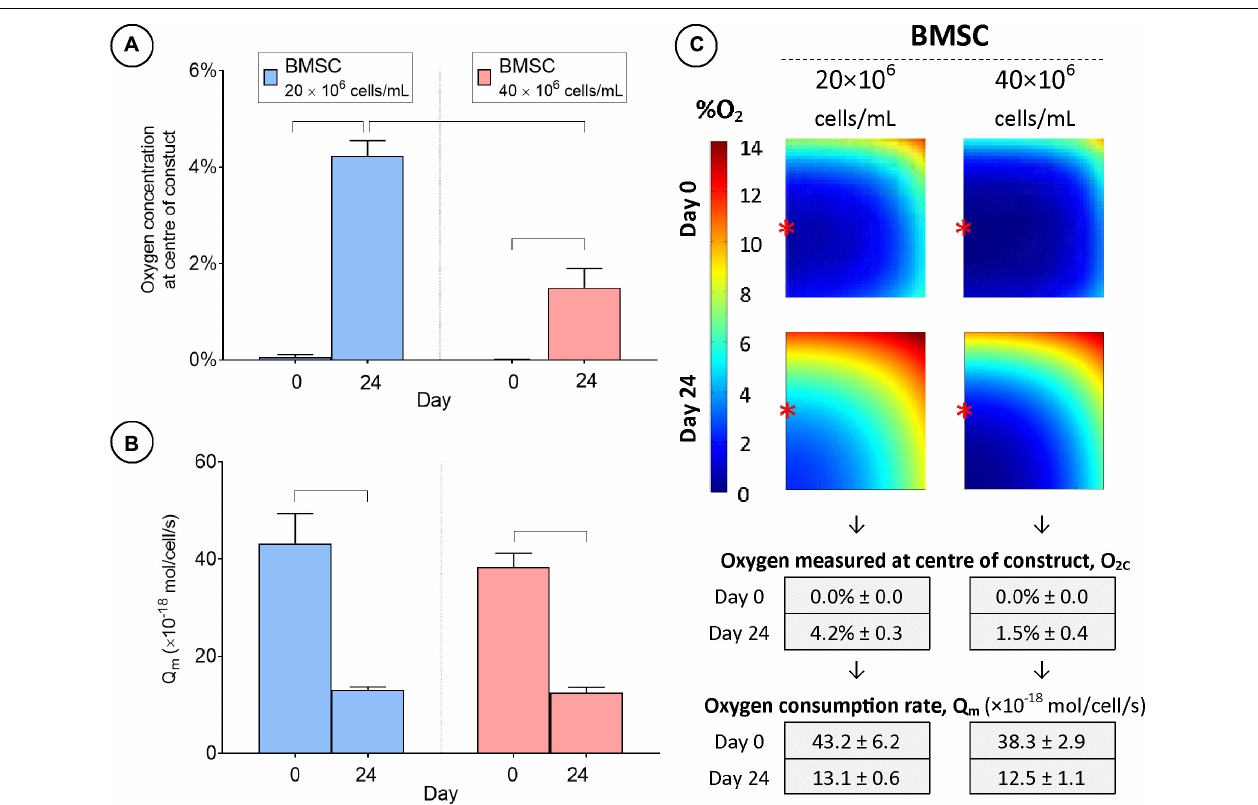
FIGURE 8 | Cartilage tissue grafts engineered using bone marrow MSCs were seeded initially at a density of either 20 or 40 million cells/mL and cultured for 24 days. (A) Oxygen concentration at center of constructs. (B) Cellular oxygen consumption rate extrapolated from FE model. (C) FE contour plots showing predicted oxygen gradients and table of values from (A,B) ( ± SD). Significant differences between groups are indicated where P < 0.05 ( n = 3). ∗ Indicates the location of oxygen sensor measurement within the